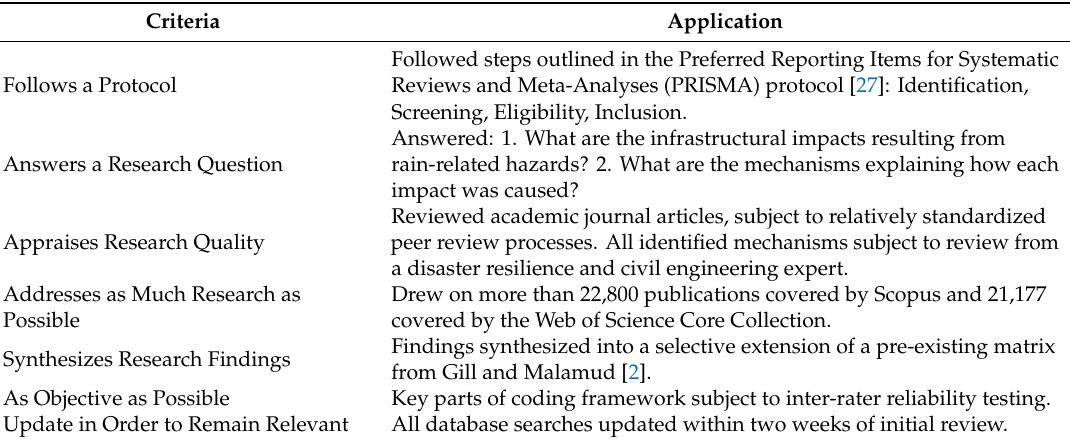
Table 1. Review criteria applied to the current